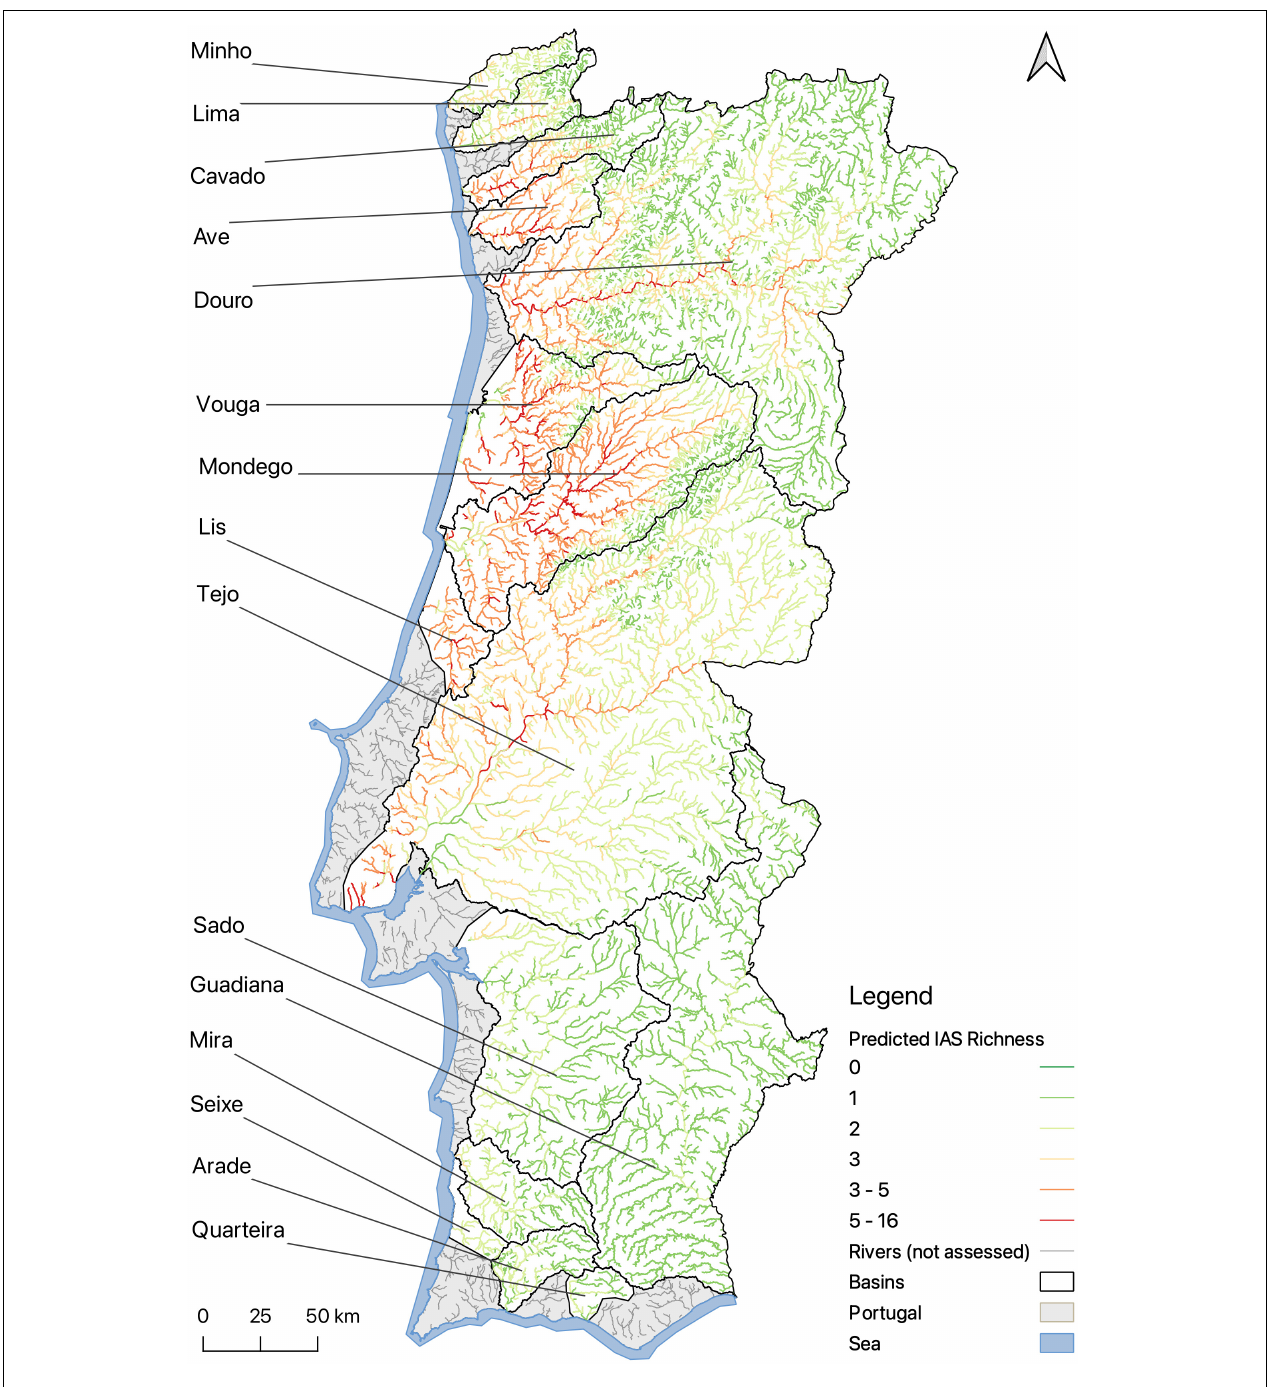
FIGURE 3 | Predictions of invasive alien plant species richness for the Portuguese river network. Richness values are calculated for each 1 km grid cell corresponding to a river section. Gray areas correspond to river basins that did not have sufficient data to be included in the analysis. This figure was created with QGIS Version 3.14 (QGIS Development Team,